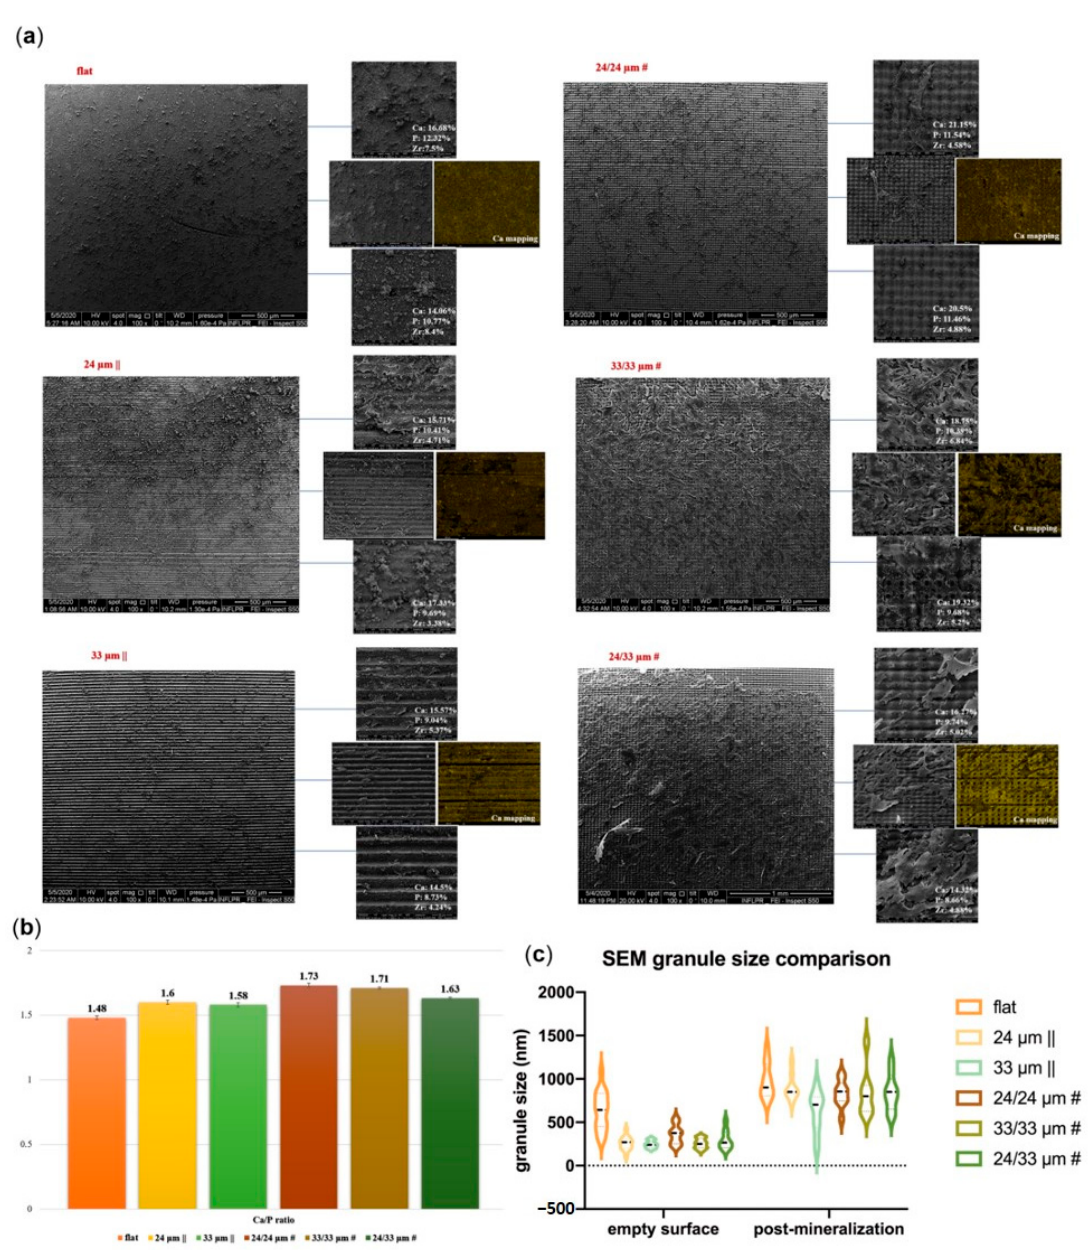
Figure 10. Chemical and physical analysis of material surfaces after human mesenchymal stem cell hMSC osteogenic differentiation. ( a ) Scanning electron microscopy (SEM) images of hMSCs cultured for 28 days on Zirconia bio-interfaces and their corresponding EDAX measurements. Low- and high-magnification SEM images are presented representing each of the structured zirconia substratum. The atomic percentage chemical composition from the EDAX is presented along with the representative SEM magnified images. EDAXareamappingsalsowereperformedtodetectCaelement. ( b )Ca / Pratioattheendofthedifferentiation process (28 days). ( c ) Granule size assessment on SEM images before and after